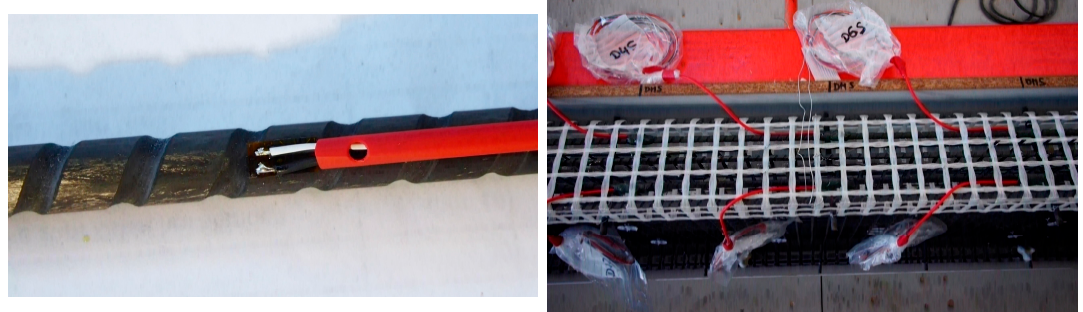
Figure 4. Left: Detail of internal strain gauge for carbon bar; right: position of strain gauges for FT01 Figure 4. Left : Detail of internal strain gauge for carbon bar; right : position of strain gauges for FT01 in tension chord. in tension